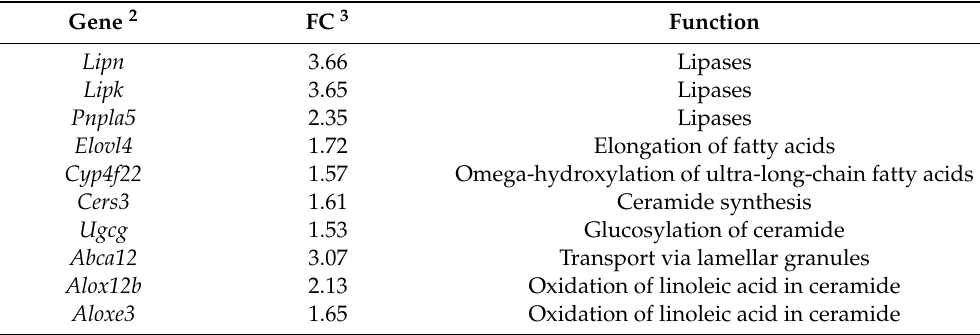
Table 2. Up-regulated genes associated with epidermal lipase, acyl-Cer synthesis and CLE formation in group HCO + BO 1. Gene 2 FC 3 Function